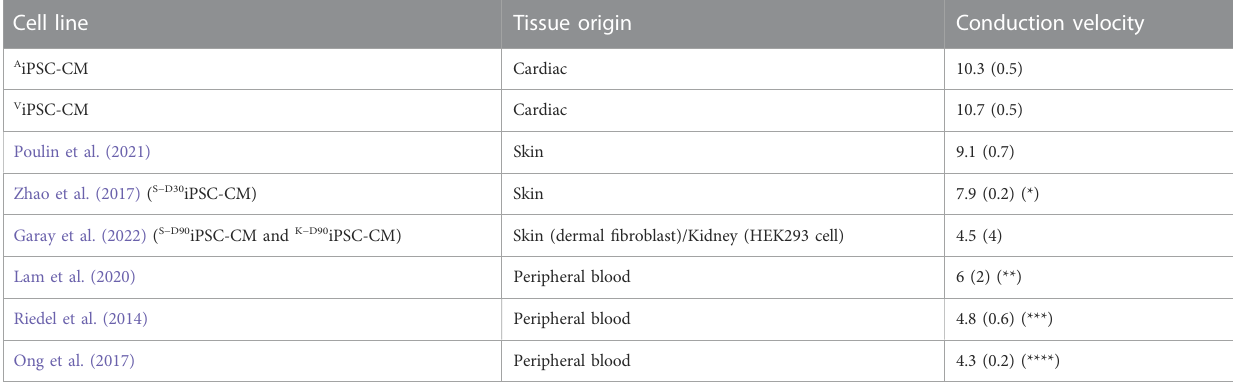
K − D90 iPSC-CM (Figure 5D). Gene ontology analysis of the 1081 DE genes (fold change > 2 see method section) identi fi ed 44 terms, some of them related to heart function (Supplementary Table S5). Further analysis identi fi ed 12 genes (AKAP9, BIN1, CACNA1G, CACNB2, CAV1, DSP, GJA5, IRX3, NKX2-5,